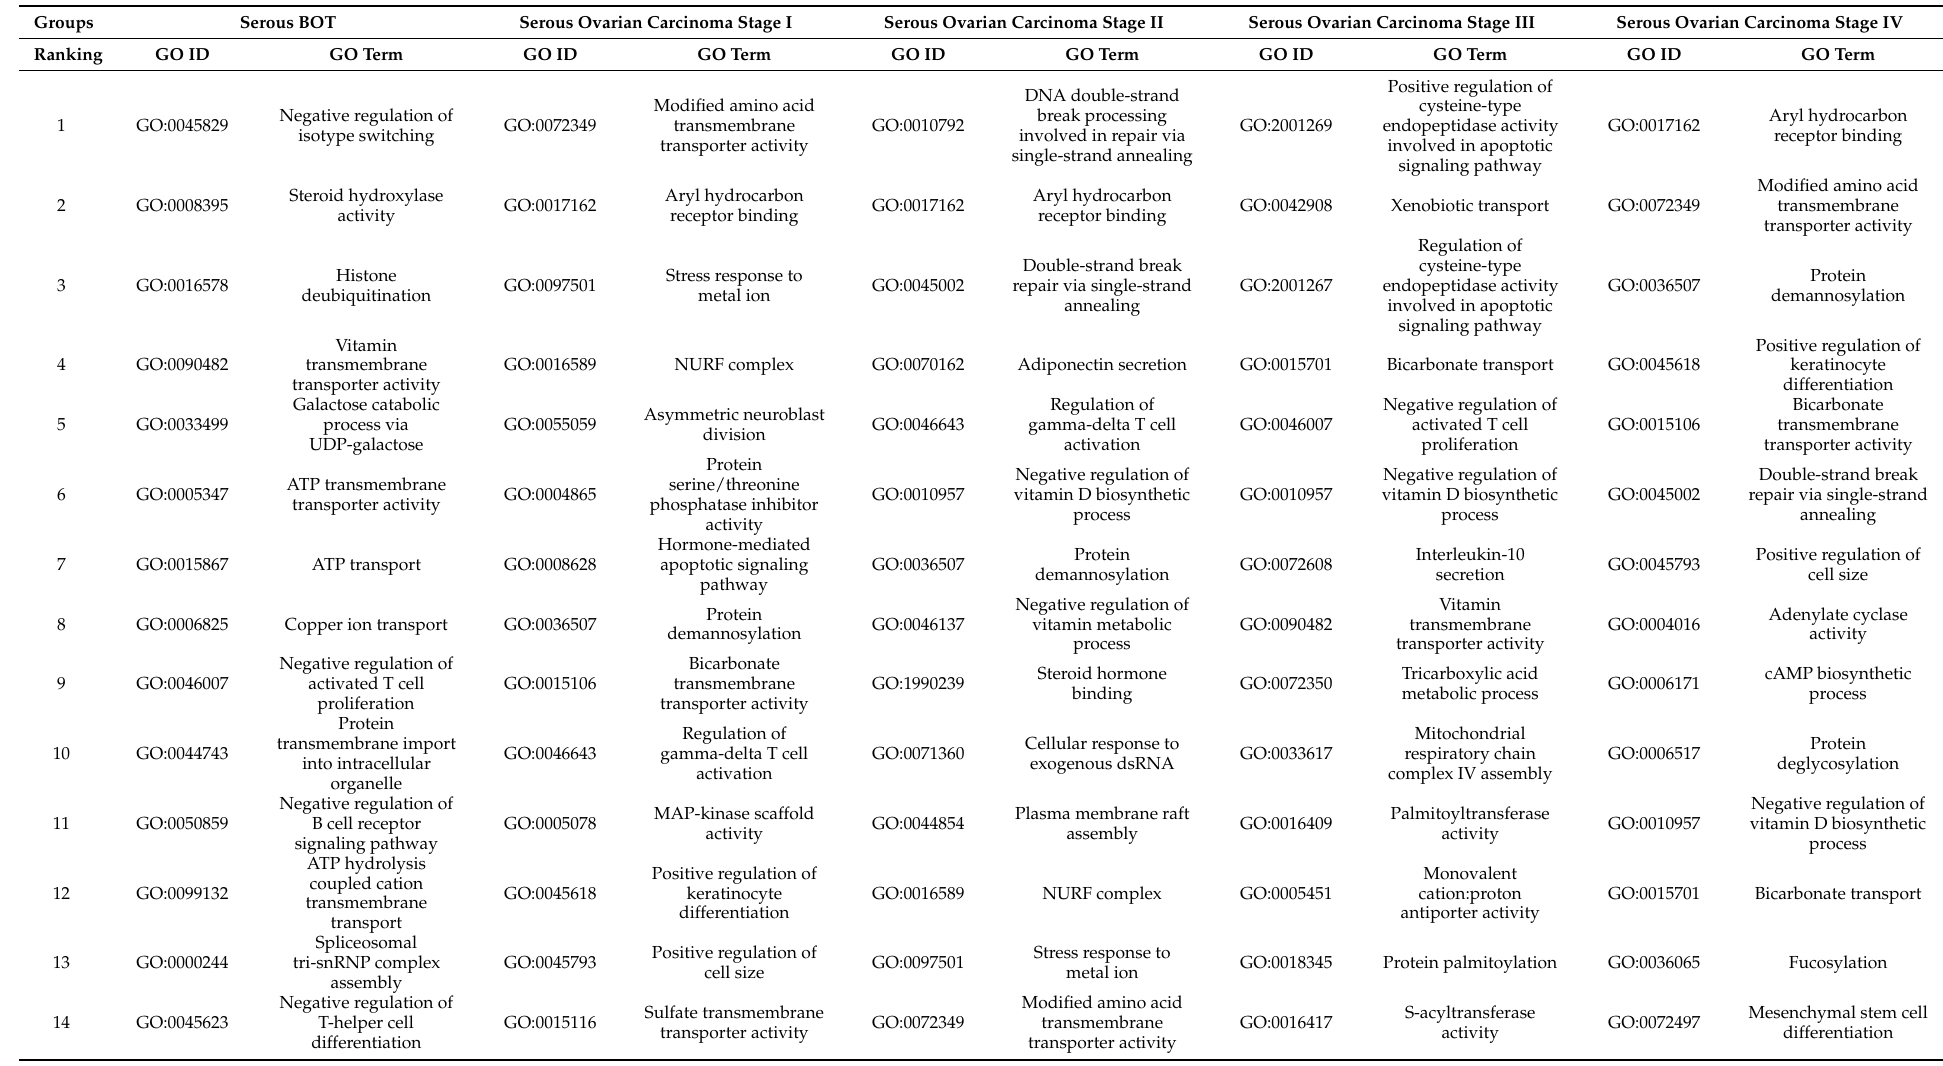
Table 4. The top 50 most dysfunctional GO-defined pathways among serous BOT and all stages of serous ovarian carcinoma ranked by p